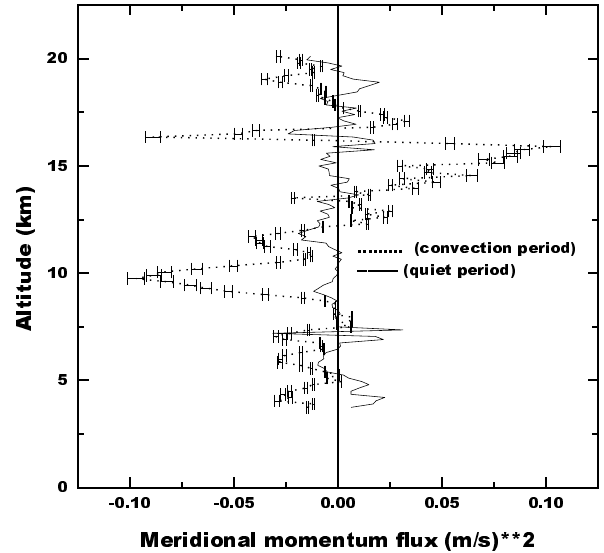
Fig. 15. The average meridional momentum flux during the convec- tion event (dotted line with error bar) and during a period without convection (full line) on 28 August